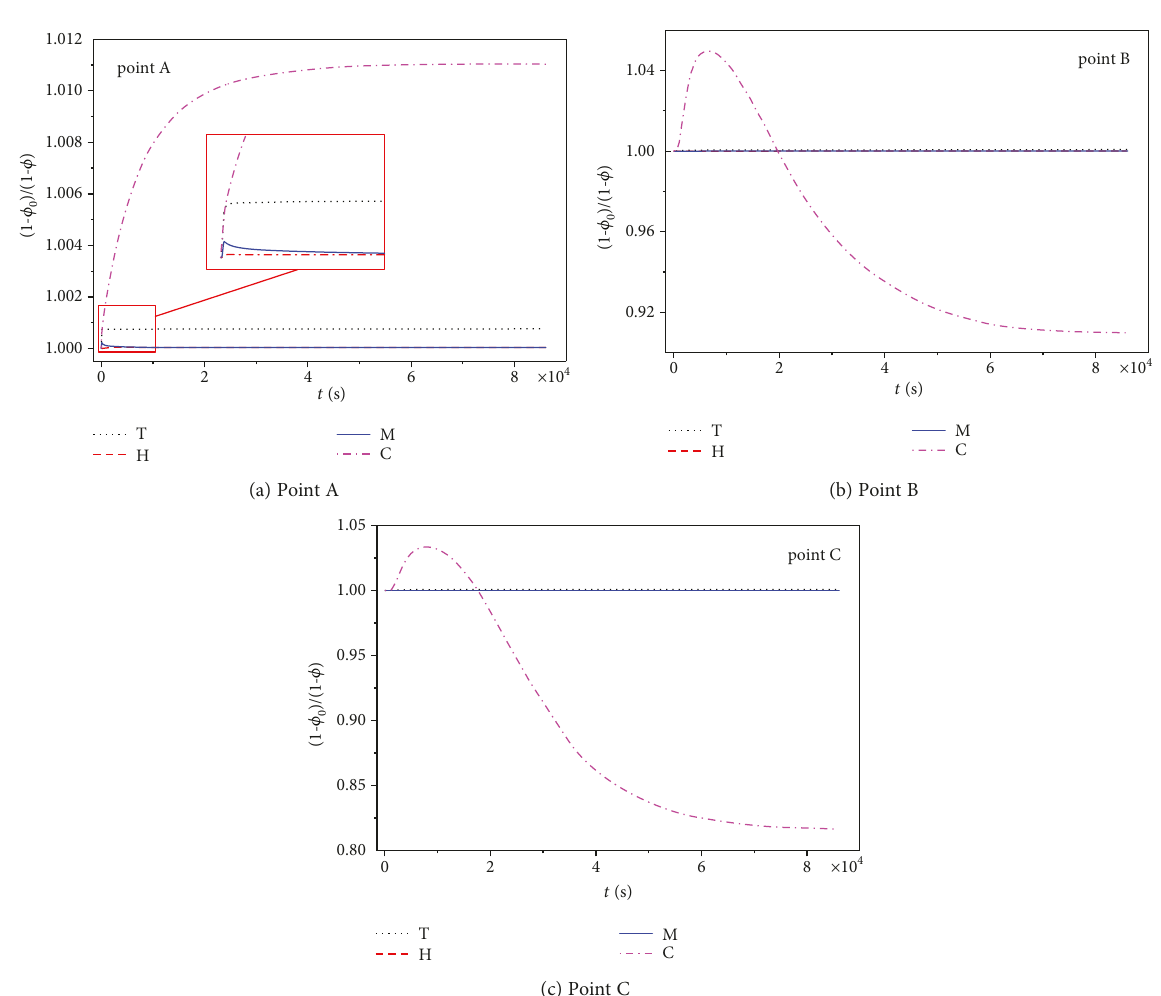
Figure 11. Apparent from Figure 11 is that the permeabil-